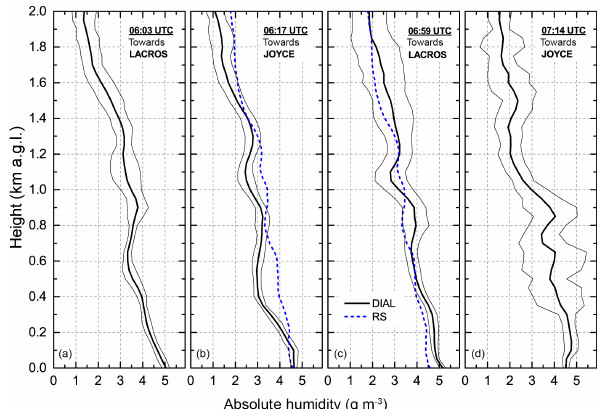
Figure 7. Spatially averaged humidity profiles of the scanning mea- surements of Fig. 6. The profiles in (a) are of the scans towards LACROS and in (b) towards JOYCE. The thick solid lines show the mean profiles of each scan and the thin lines indicate the hor- izontal variability of humidity (1 σ standard deviation) within the scan range. The radiosonde profile at 07:00 UTC was plotted with a dashed line with the two closest scans ( b and c